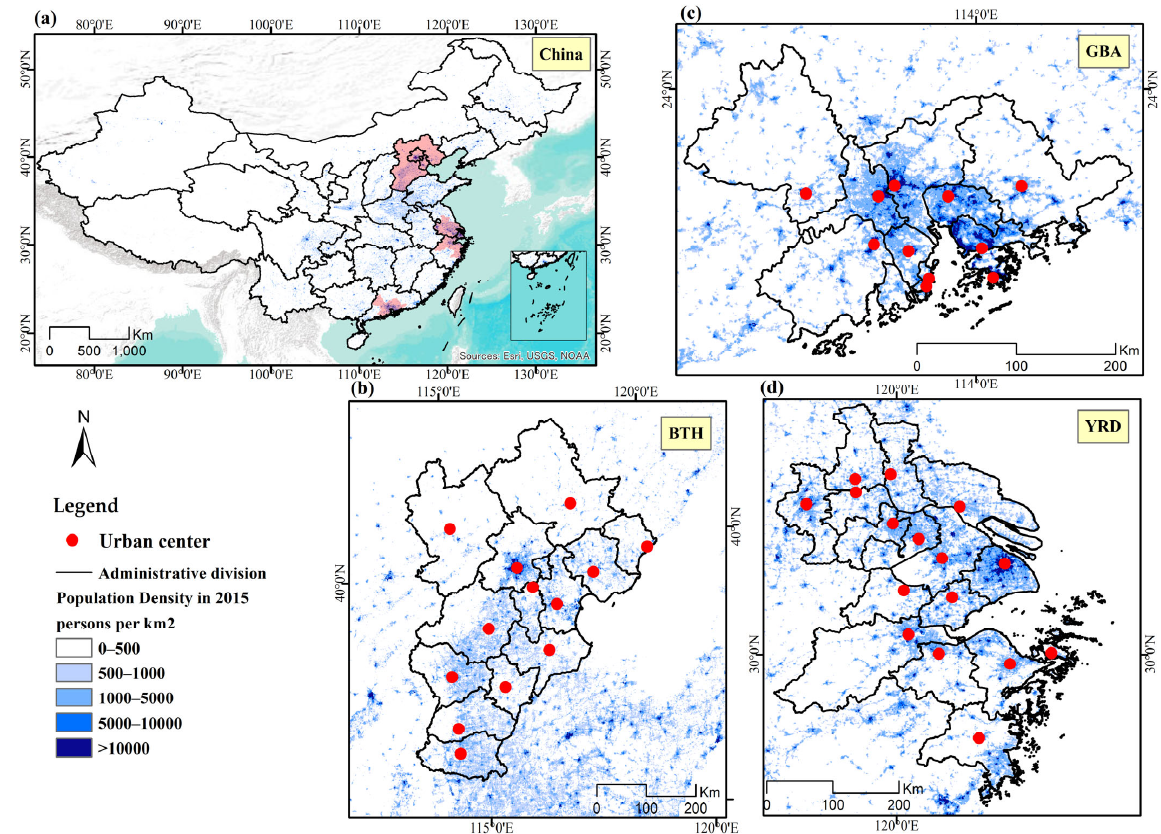
Figure 1. Study areas: ( a ) geographic location of the study areas in China; ( b ) Beijing–Tianjin–Hebei (BTH); ( c ) Guangdong–Hong Kong–Macao Greater Bay Area (GBA); and ( d ) Yangtze River Delta (YRD). At the end of 2015, approximately 8%, 5%, and 11% of the national population resided in BTH, GBA, and YRD, respectively [45]. BTH, GBA, and YRD had 10.2%, 14%, and 18.5% of